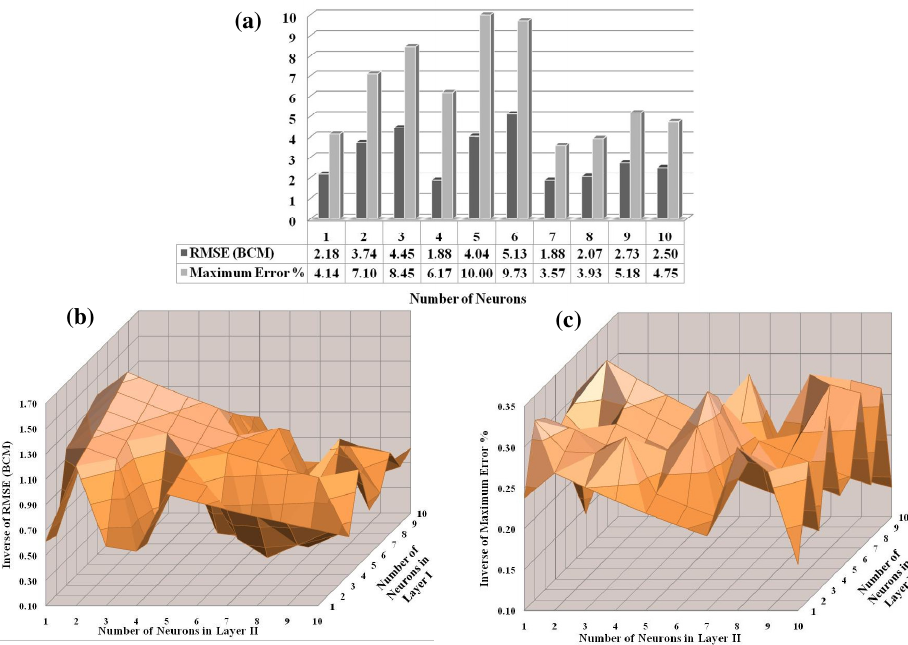
Fig. (10). Neural Network Performance “RMSE and maximum error%” utilizing Fig. 10. Neural Network Performance “RMSE and maximum error%” utilizing different Architecture, (a) one hidden layer (b) and (c) two different Architecture, (a) one hidden layer (b) & (c) two hidden layers hidden